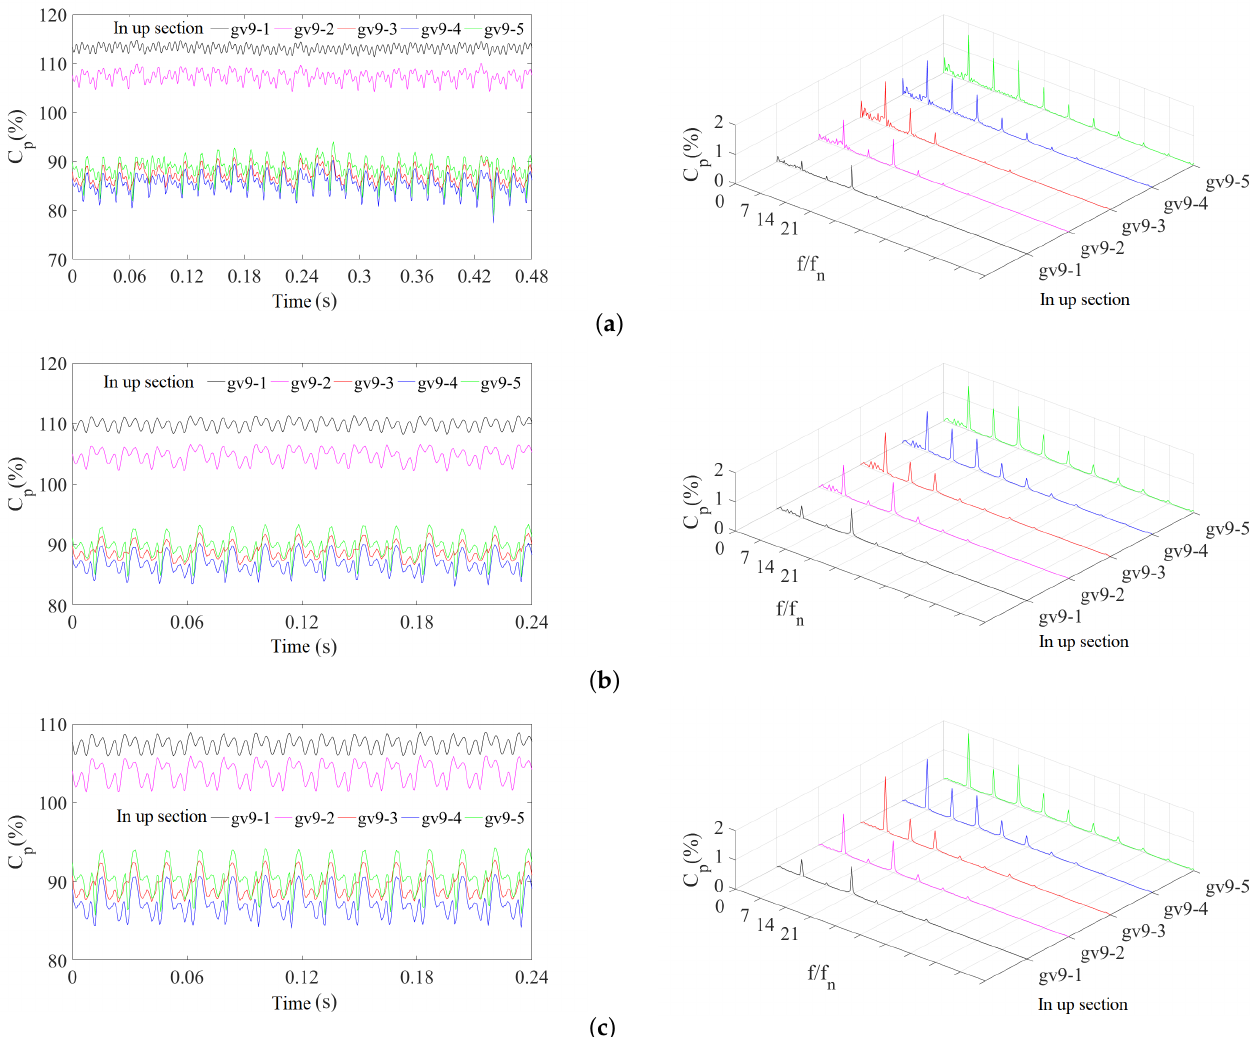
Figure 13. Time–domain and frequency–domain diagrams of pressure fluctuations of the monitoring points along the flow direction in guide vane passage. ( a ) 60% load condition. ( b ) 86.7% load condition. ( c ) 100% load